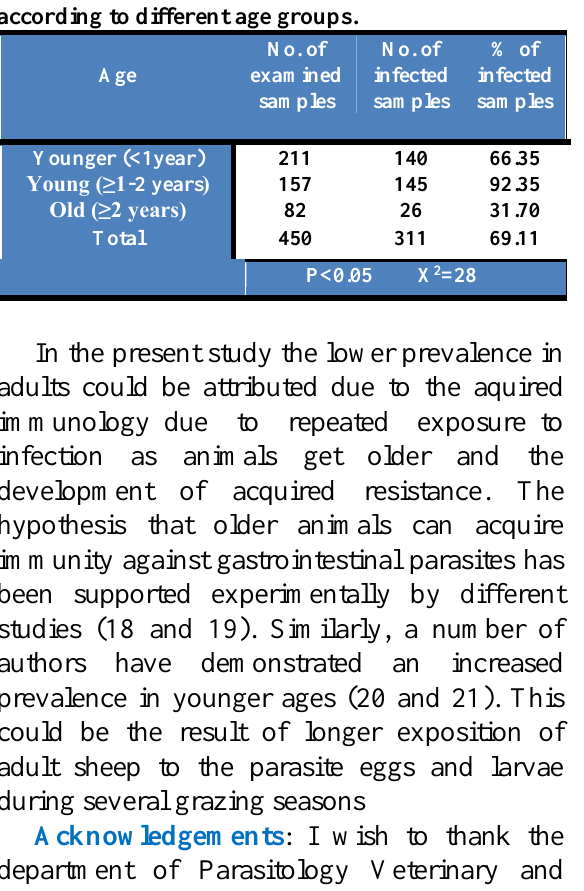
3: Abomasal helminth infection rates according to different age groups.